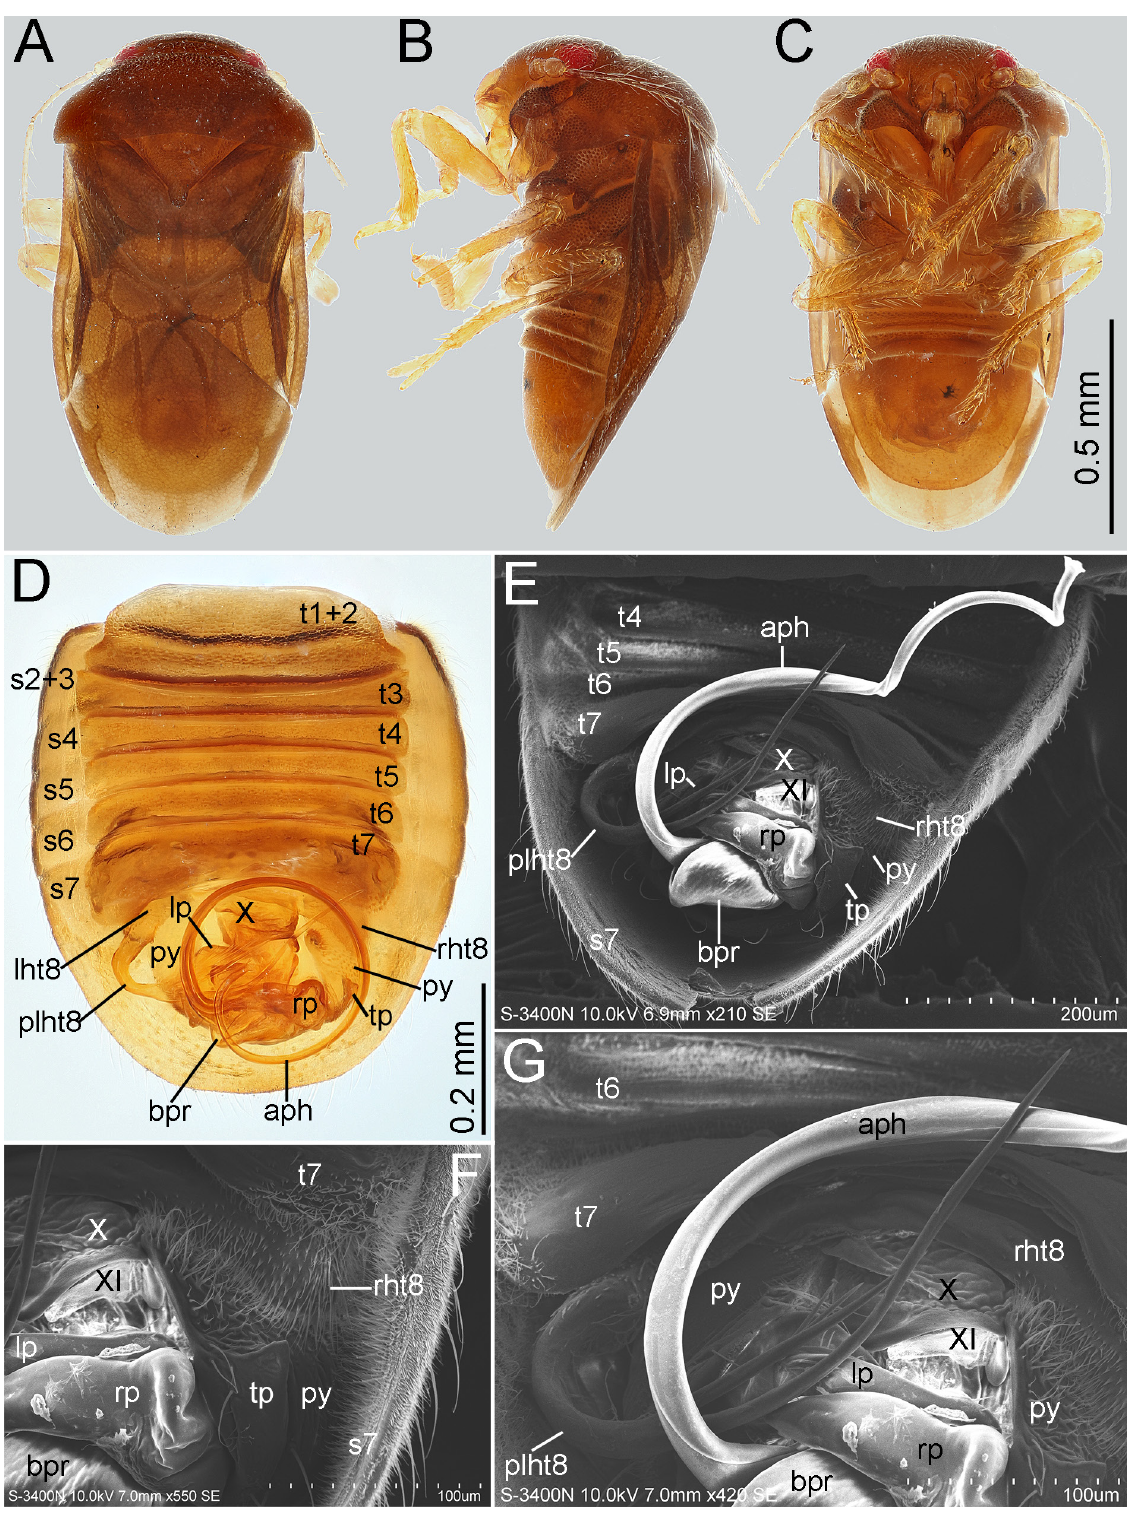
Fig. 13. Kokeshia hsiaoi Ren & Zheng, 1992. A‒C . Habitus, ♂ (SYSBM). A . Dorsal view. B . Lateral view. C . Ventral view. D . Pregenital abdomen and genitalia, dorsal view, ♂ (SYSBM). E‒G . Scanning electron micrographs of genitalia, ♂ (SYSBM). E . Dorsal view. F . Right side, dorsal view. G . Left side, dorsal view. Abbreviations: see Material and